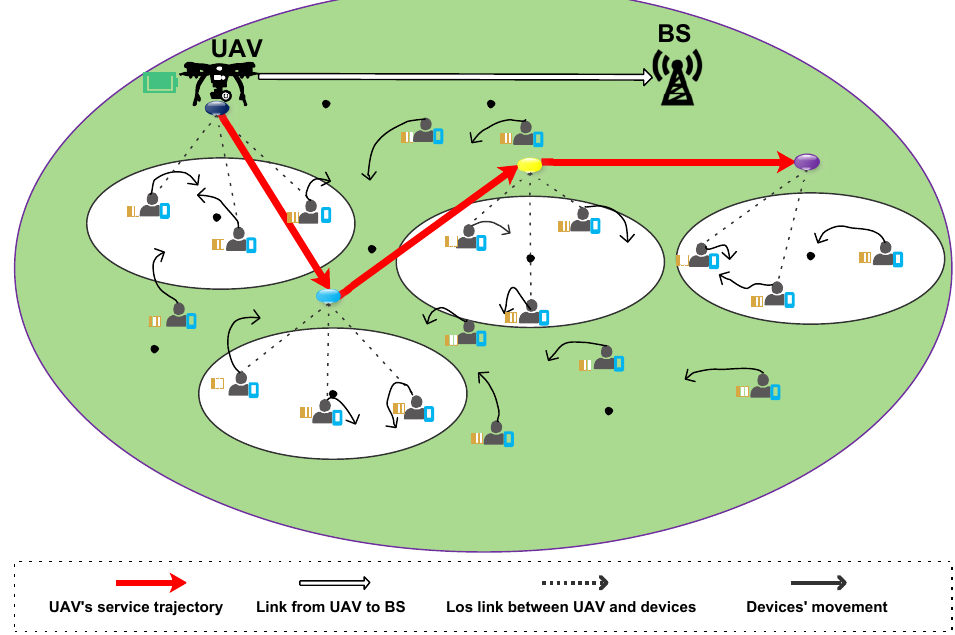
Figure 1. The system model of UAV-assisted edge computing networks consists of a UAV and multiple mobile